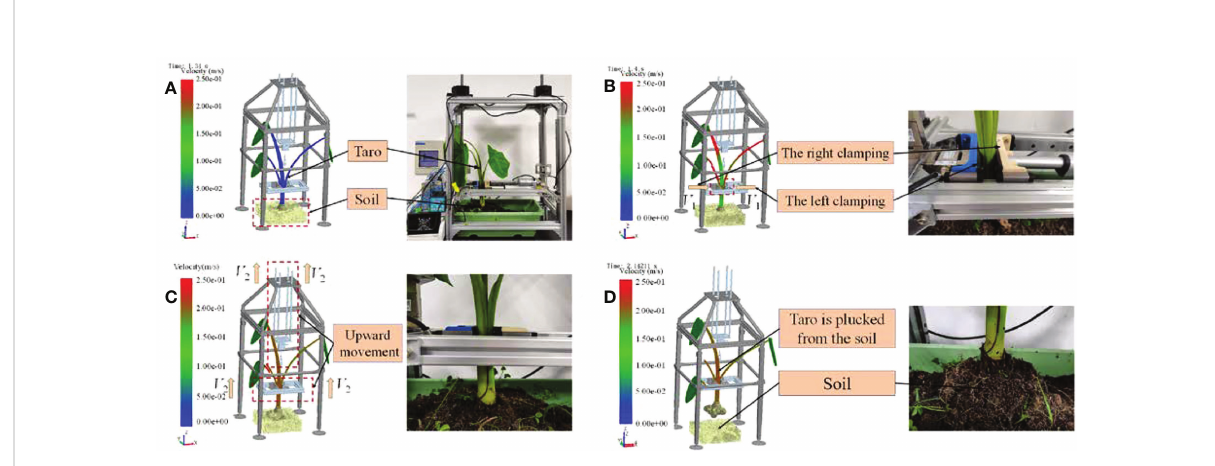
FIGURE 6 DEM simulation process. (A) The taro petiole is placed in the middle of the gripper; (B) The left and right clamping boards clamp the taro petiole; (C) The ascending mechanism lifts the taro plant; (D) Taro is completely pulled from the